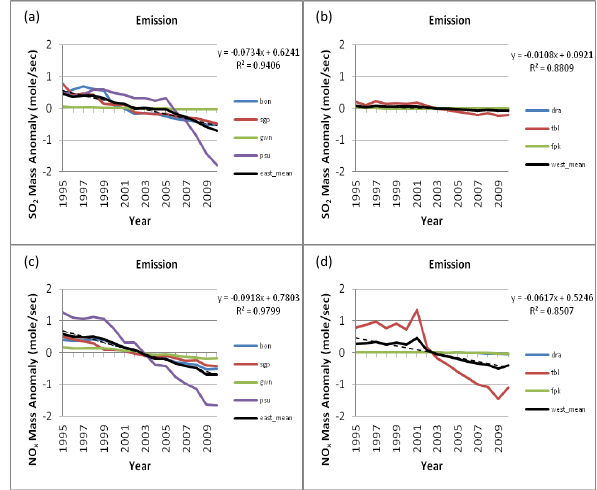
Figure 2: Annual anomalies of SO 2 (first row) and NO x (second row) emission for each site 3 Fig. 2. Annual anomalies of SO 2 (top row) and NO x (bottom row) (colored line) and the network mean (solid black line) together with the LSF (dash black line) 4 emission for each site (colored line) and the network mean (solid to the network mean. The best-fit equation and coefficient of determination (R 2 ) are given at 5 black line) together with the LSF (dash black line) to the network right in each panel. The left column represent eastern US while the right column represent 6 mean. The best-fit equation and coefficient of determination ( R 2 ) are given at right in each panel. The left column represents eastern US while the right column represents western